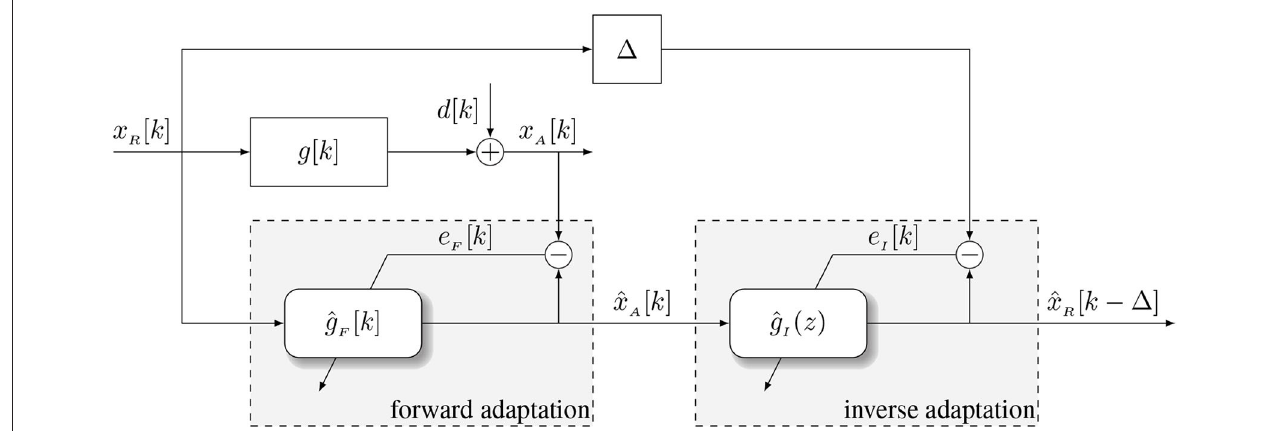
FIGURE 3 | The learning process of the adaptive inverse